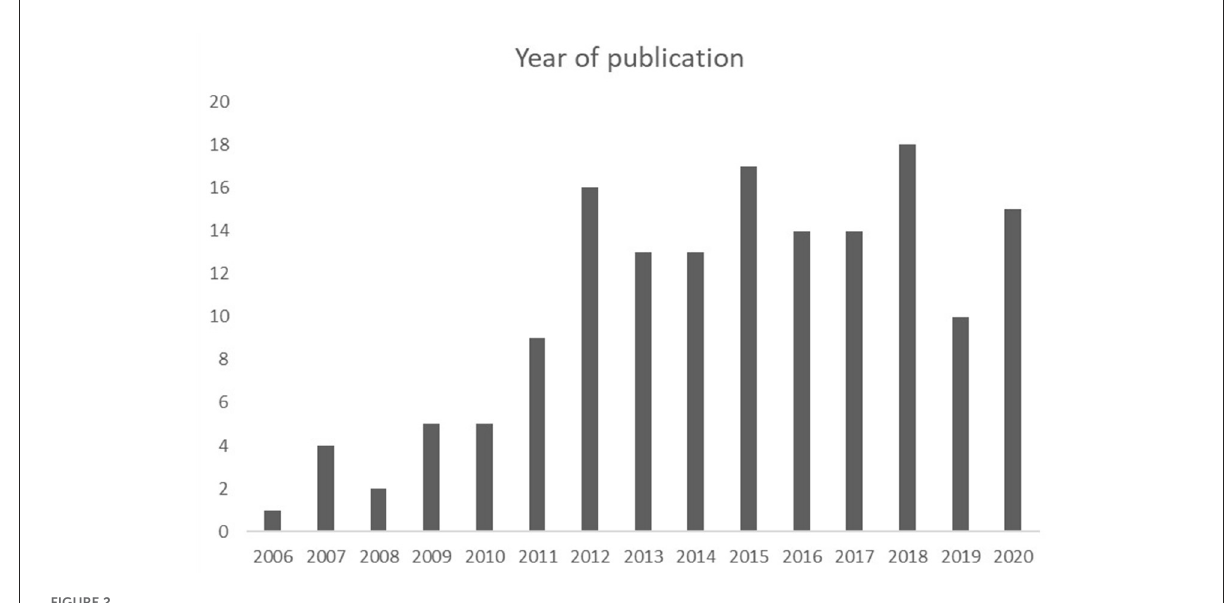
FIGURE2 Year of publication (between 2006 and 2020) of the 161 relevant manuscripts included in our systematic